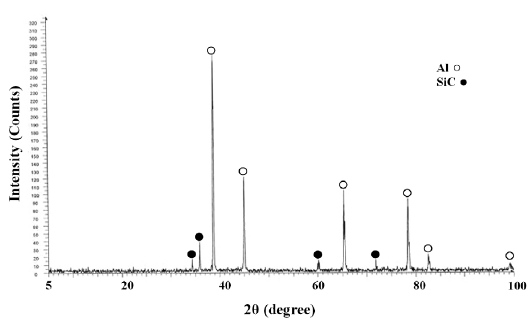
Figure 1. XRD pattern of the mixture of as-received